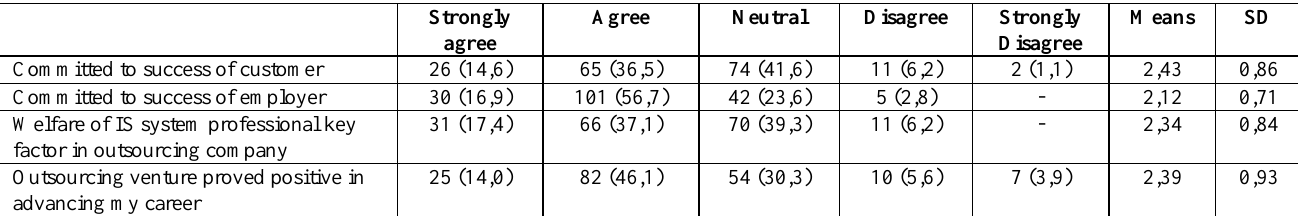
Strongly Agree Neutral Disagree Strongly agree 23(12,9) 92(51,7) 14 (7,9) 0 2,03 0,79 36 (20,2) 14 (7,9) 11 (6,2)